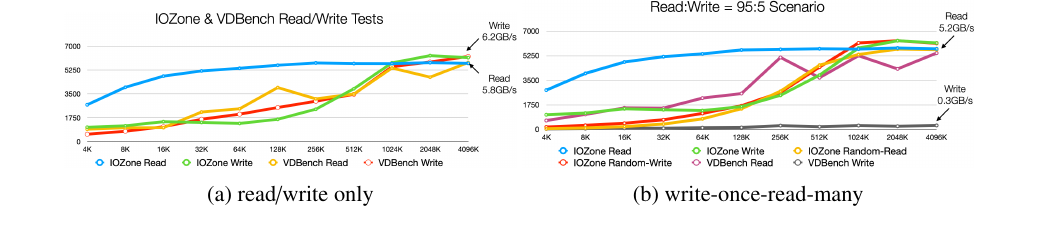
Figure 4: The read / write test results on di ff erent scenarios